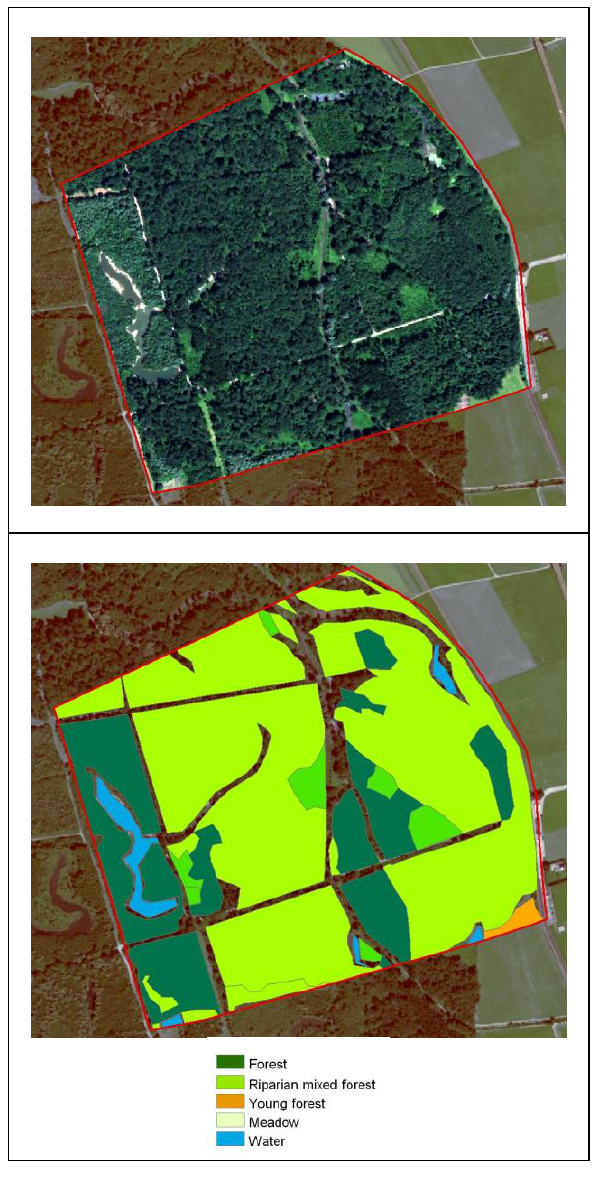
Figure 2. The study area showing the WV-2 image (above) and the visual interpretation of the same area, done by an ecological expert (below).